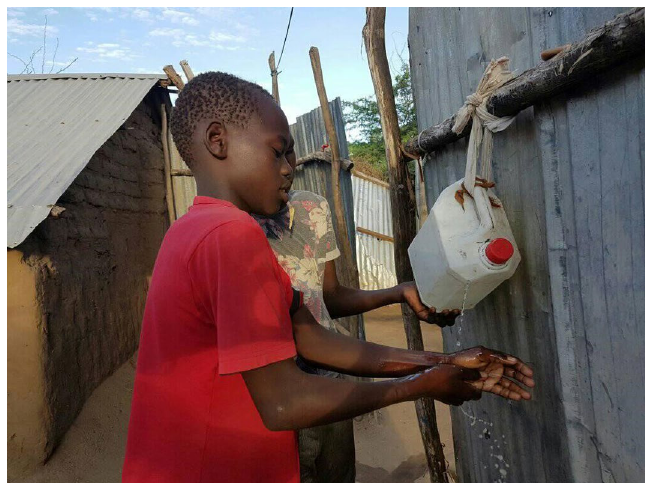
Fig. 3 Brando Atiol, A young student (6th grade) from Jebel Marra Primary School in Kakuma Refugee Camp washes his hands on a canister that he has converted into a faucet with soap installed above it.